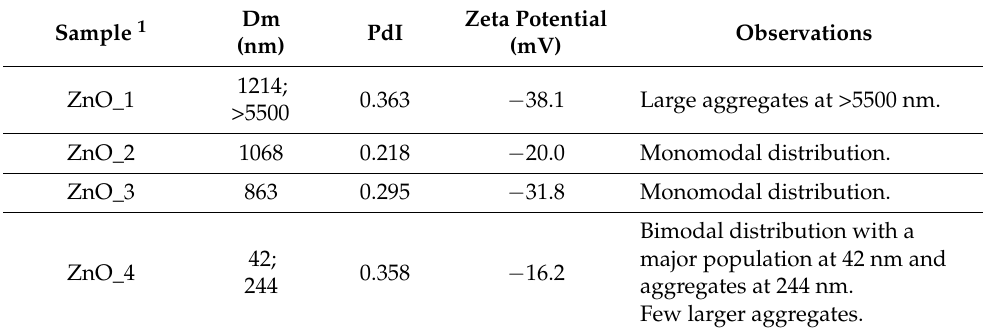
Table 2. The size, size distribution and zeta potential of the ZnO samples prepared in the microwave irradiation using various capping and structuring